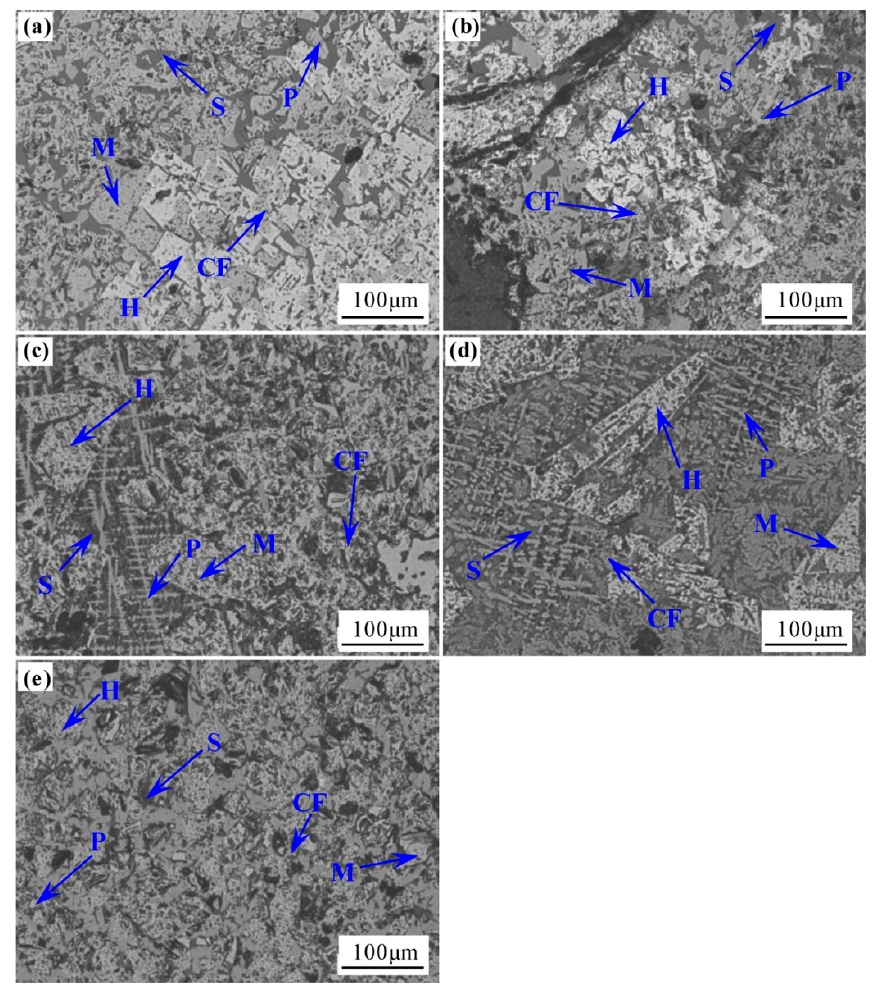
Figure 5. Microstructure of HCVTM sinter with different MgO content. M: magnetite; H: hematite; P: perovskite; CF: calcium ferrite; S: silicate. ( a ) MgO = 2.7%; ( b ) MgO = 2.9%; ( c ) MgO = 3.1%; ( d ) MgO = 3.3%; ( e ) MgO = 3.5% .